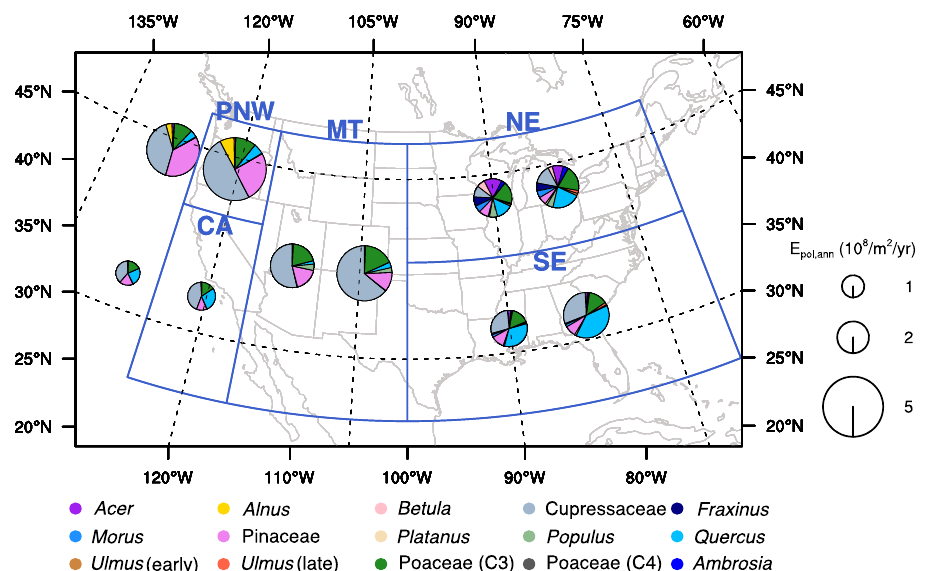
Fig. 5 Average annual total pollen emission in the historical and future. Regional average annual total pollen emission (E pol,ann , unit: 10 8 grains m − 2 yr − 1 ) in the historical (left; 1995-2014) and future shared socioeconomic pathway (SSP) 585 scenario (right; 2081-2100) for the 5 geographic regions (Northeast (NE), Southeast (SE), Mountain (MT), California (CA), and Paci fi c Northwest (PNW). Chart size indicates the amount of total pollen emitted and different colors represent the contribution of different taxa. The data used here are provided as source data fi